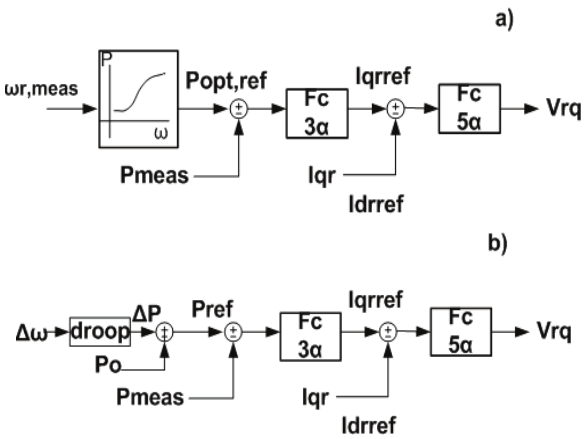
(b) active power control of the DFIG in study case without battery.